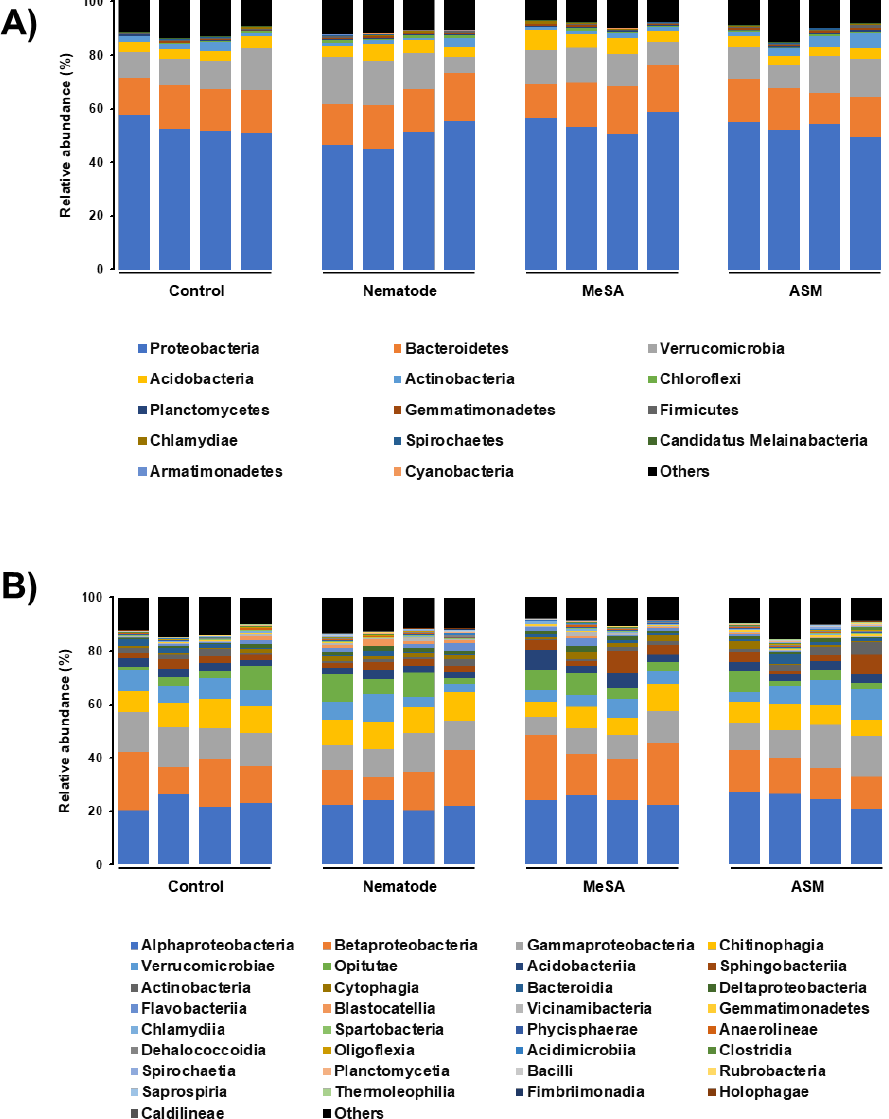
Figure 3. Stacked bar graphs representing the structure of pine rhizosphere microbiota at the phylum ( A ) and class ( B ) levels. Samples were treated with methyl salicylic acid (MeSA) or acibenzolar-s-methyl (ASM), followed by inoculation with the nematode, and compared to nematode-treated and control